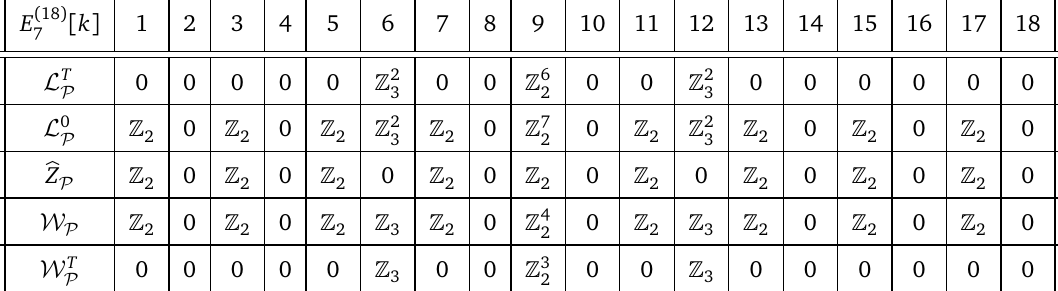
Table 12: Various contributions to the defect group for the untwisted punctures ( 18 ) [ k ] of type E N = ( 2,0 ) theory. The columns parametrize different values of P 7 7 k . The results can be extended beyond this table as they only depend on k ( mod 18 ) .